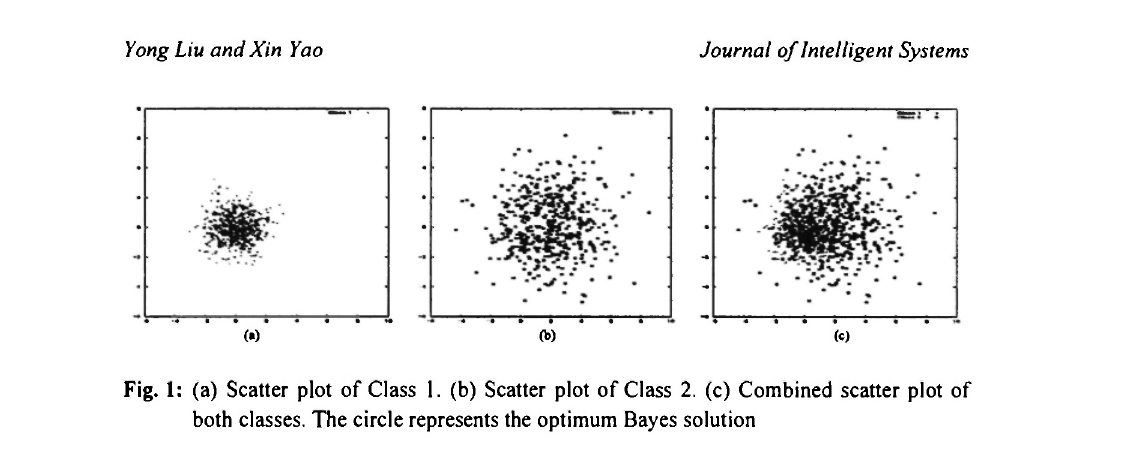
Fig. I: (a) Scatter plot of Class 1. (b) Scatter plot of Class 2. (c) Combined scatter plot of both classes. The circle represents the optimum Bayes solution